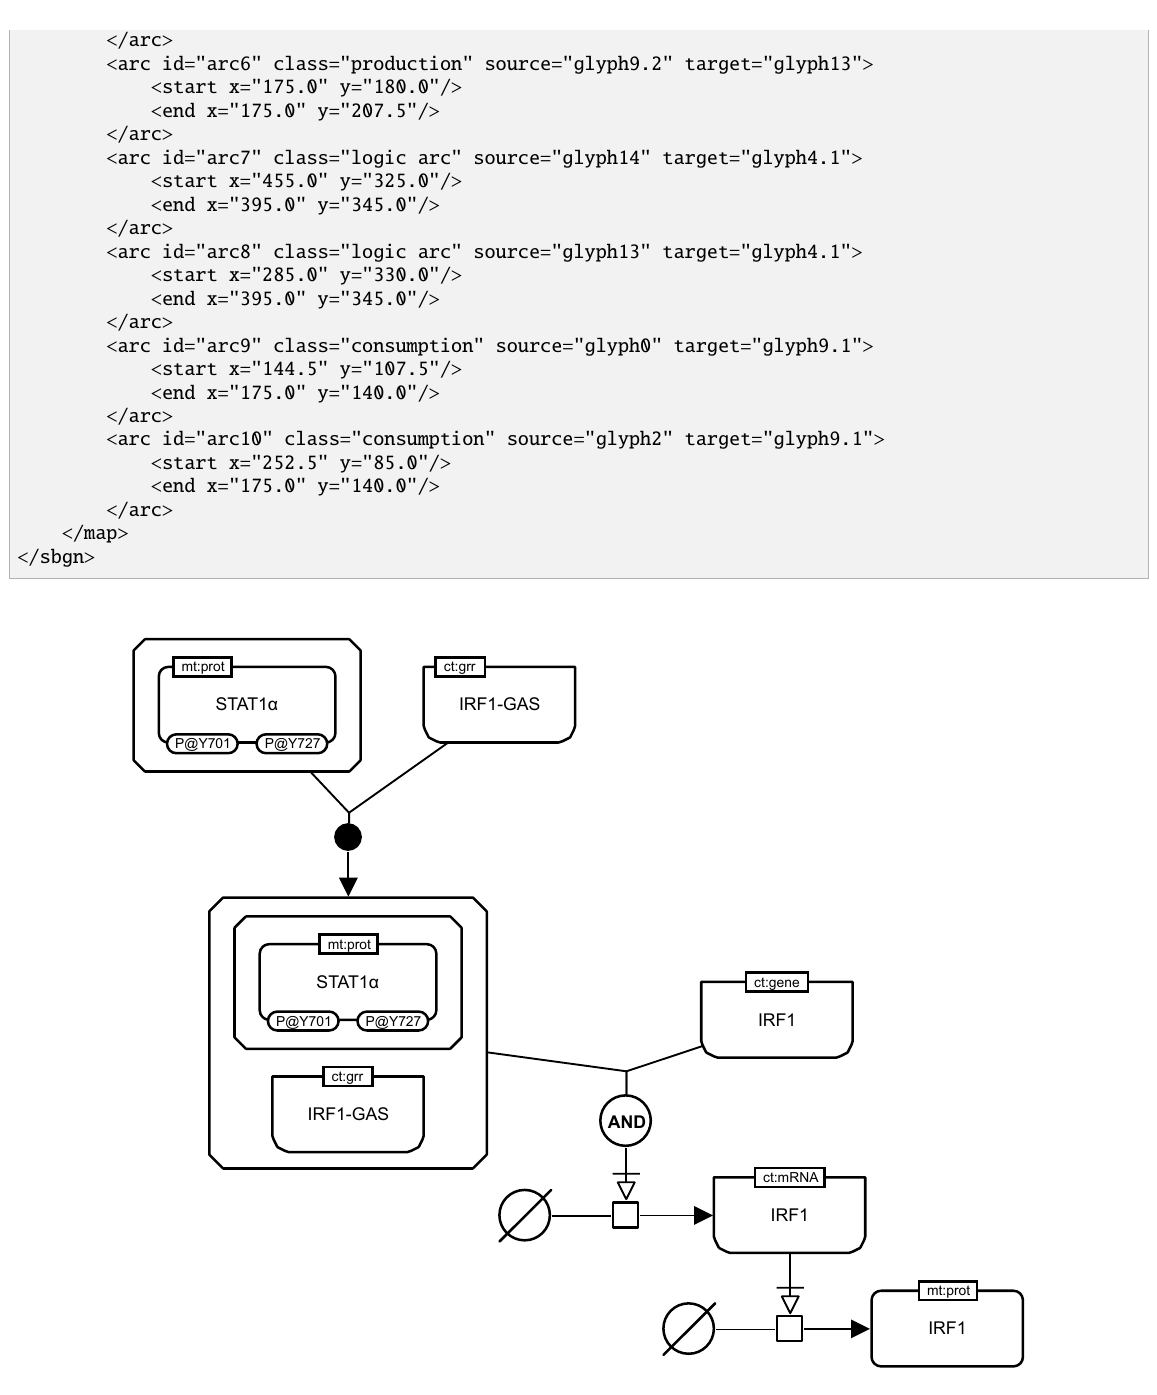
Figure 27: Activated STAT1 α induction of the IRF1